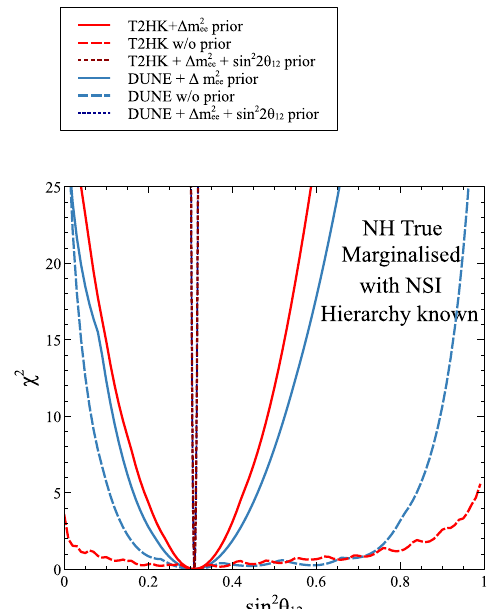
Figure 4 . χ 2 as a function of sin 2 θ 12 for mock data generated at sin 2 θ 12 = 0 . 31 . The parameters δ CP , | ∆ m 2 | and (cid:15) ee are allowed to vary freely in the fit. Shown are the sensitivity expected at 31 T2HK as well as DUNE with and without prior from